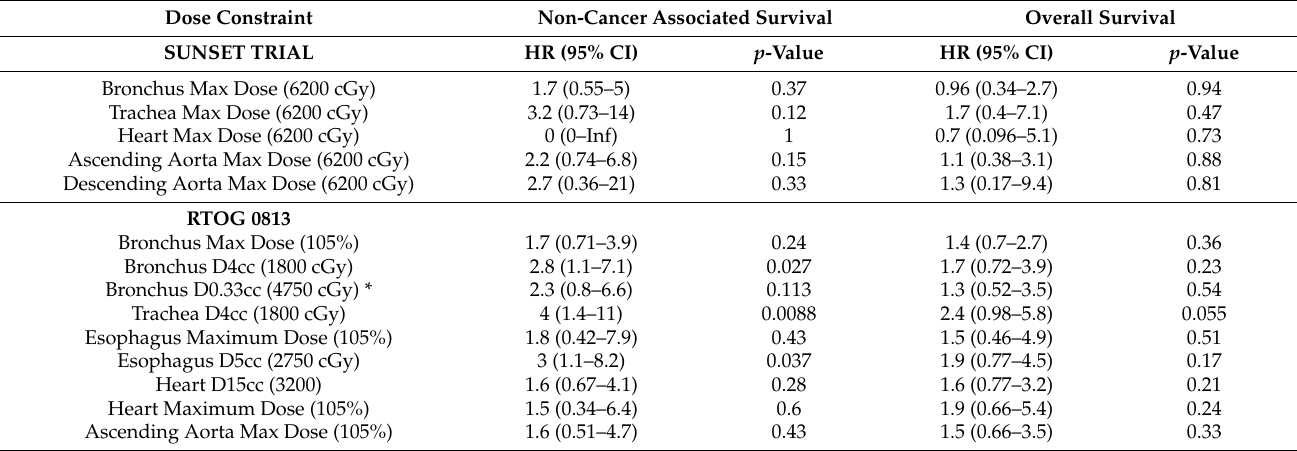
Table 5. Correlation between dose constraint failure and outcome by univariate Cox